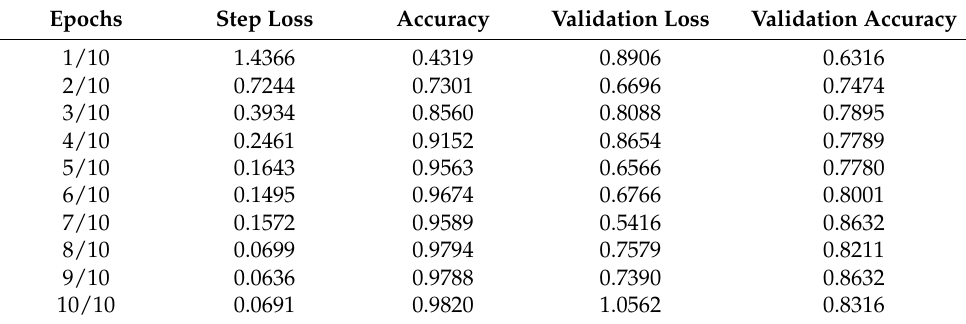
Table 1. Prescriptive data analysis for Conv2D Xception model compilation.